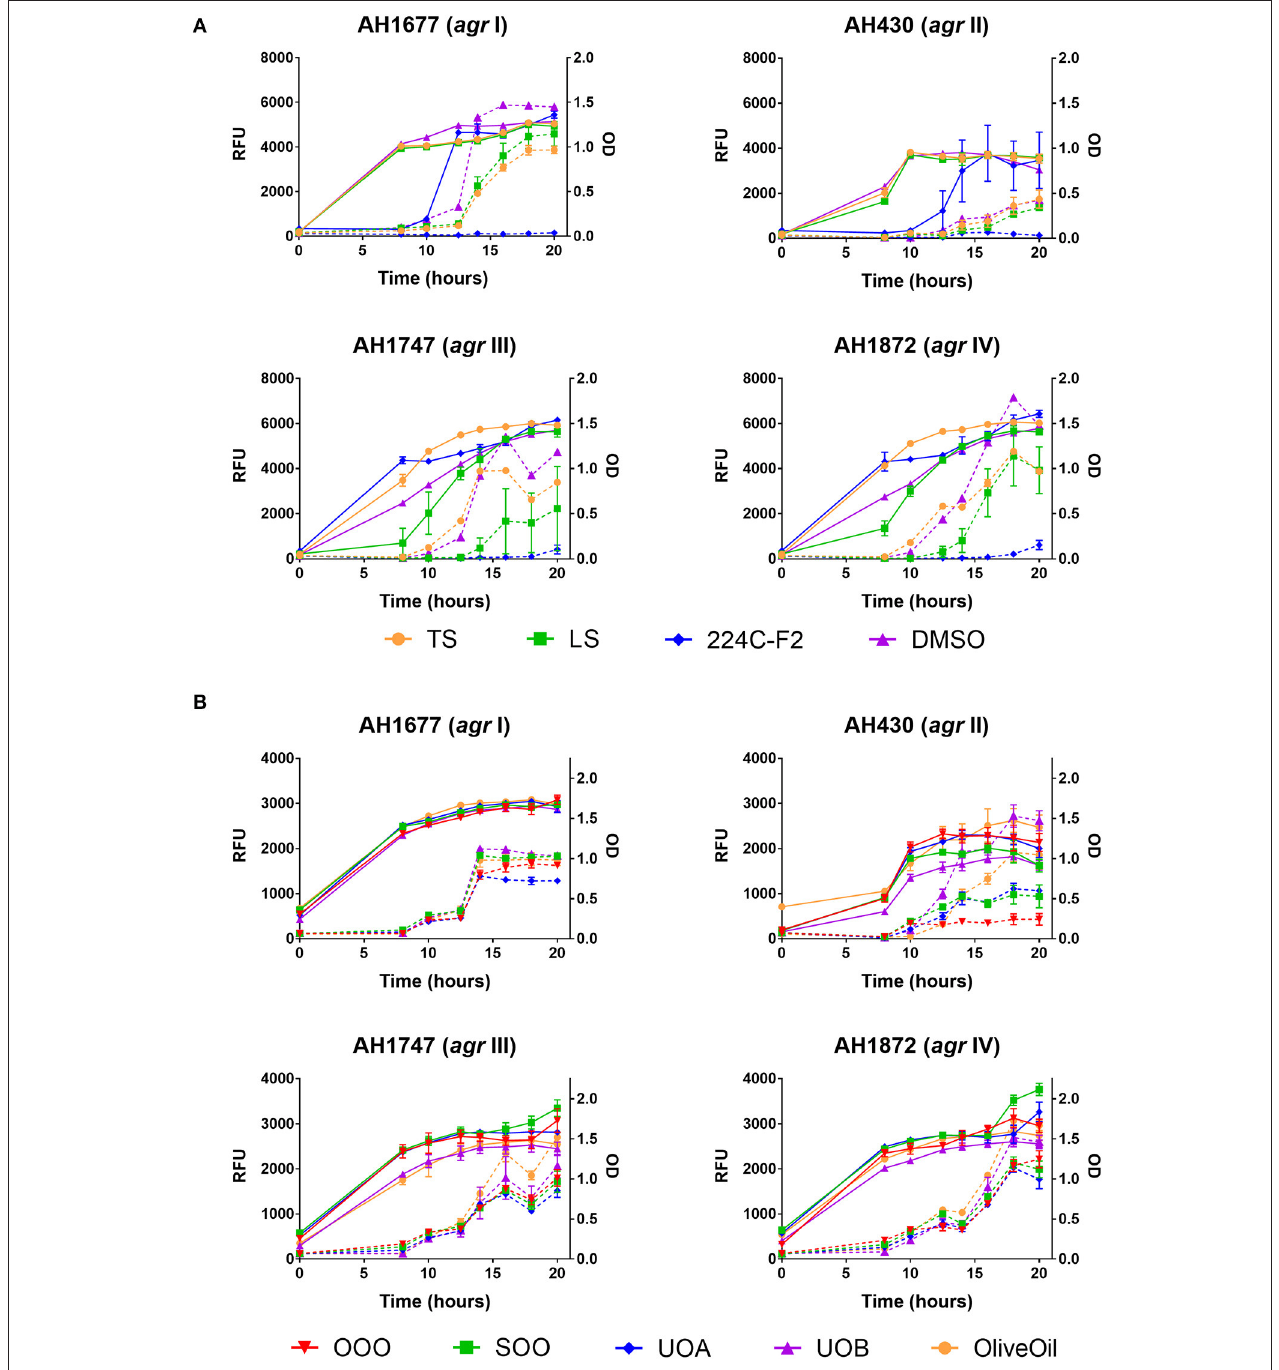
FIGURE 4 | Impact of H. perforatum commercial supplements and Oleum Hyperici samples on growth and agr activity over 20 h as determined by optical density and fluorescence measures of four S. aureus agr reporters. Solid lines in the graphs denote OD; broken lines denote RFU. (A) Organic extracts and controls. (B) Oil macerates and controls. Test concentrations correspond with results on quorum sensing inhibition reported in Table 3 . Briefly, TS and LS were tested at 32 µ g mL − 1 , DMSO (vehicle control) at eight concentrations from 0.02 to 0.64% v/v, and 224C-F2 (positive control) at eight concentrations from 0.5 to 64 µ g mL − 1 , with results from the highest concentrations for the vehicle and positive control reported here. For oil macerate tests, OOO was tested at 0.512% v/v for agr I and III, 0.064% for agr II, and 0.256% for agr IV; SOO was tested at 0.512% for agr I, III, and IV, 0.064% for agr II; UOA was tested at 0.512% for agr I, III, and IV, 0.0128% for agr II; UOB was tested at 0.512% for agr I, III, and IV, 0.0128% for agr II. Lastly, Olive Oil was tested at 8 concentrations from 0.004 to 0.512% and the highest concentration is reported here.